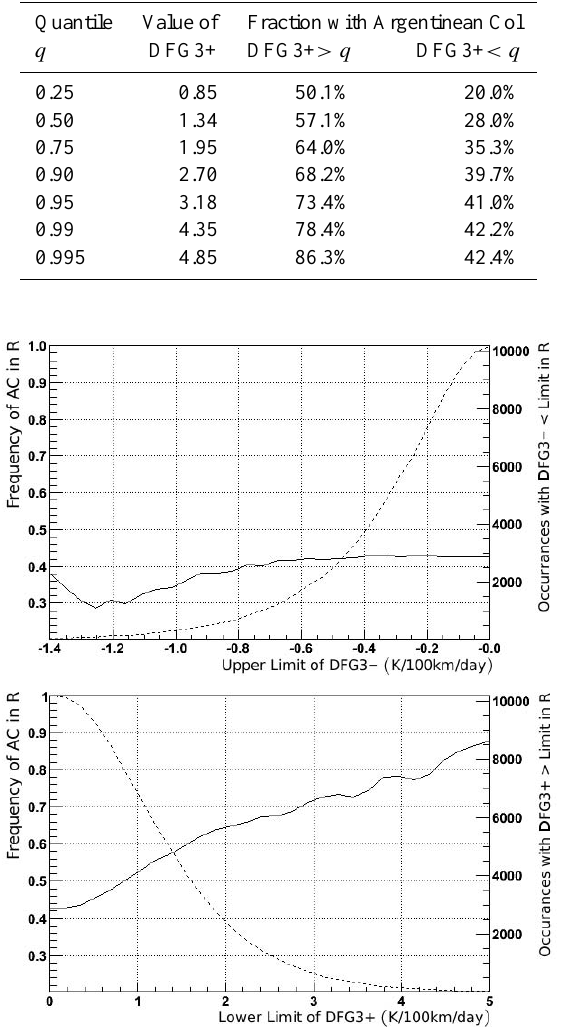
In the lower panel of Fig. 7 the dotted curve takes values in the right vertical axis and shows the total number of events above the DFG3+ thresholds shown on the x-axis. The full line curve take values in the left vertical axis and shows the AC fraction for events above the threshold. It is an expanded